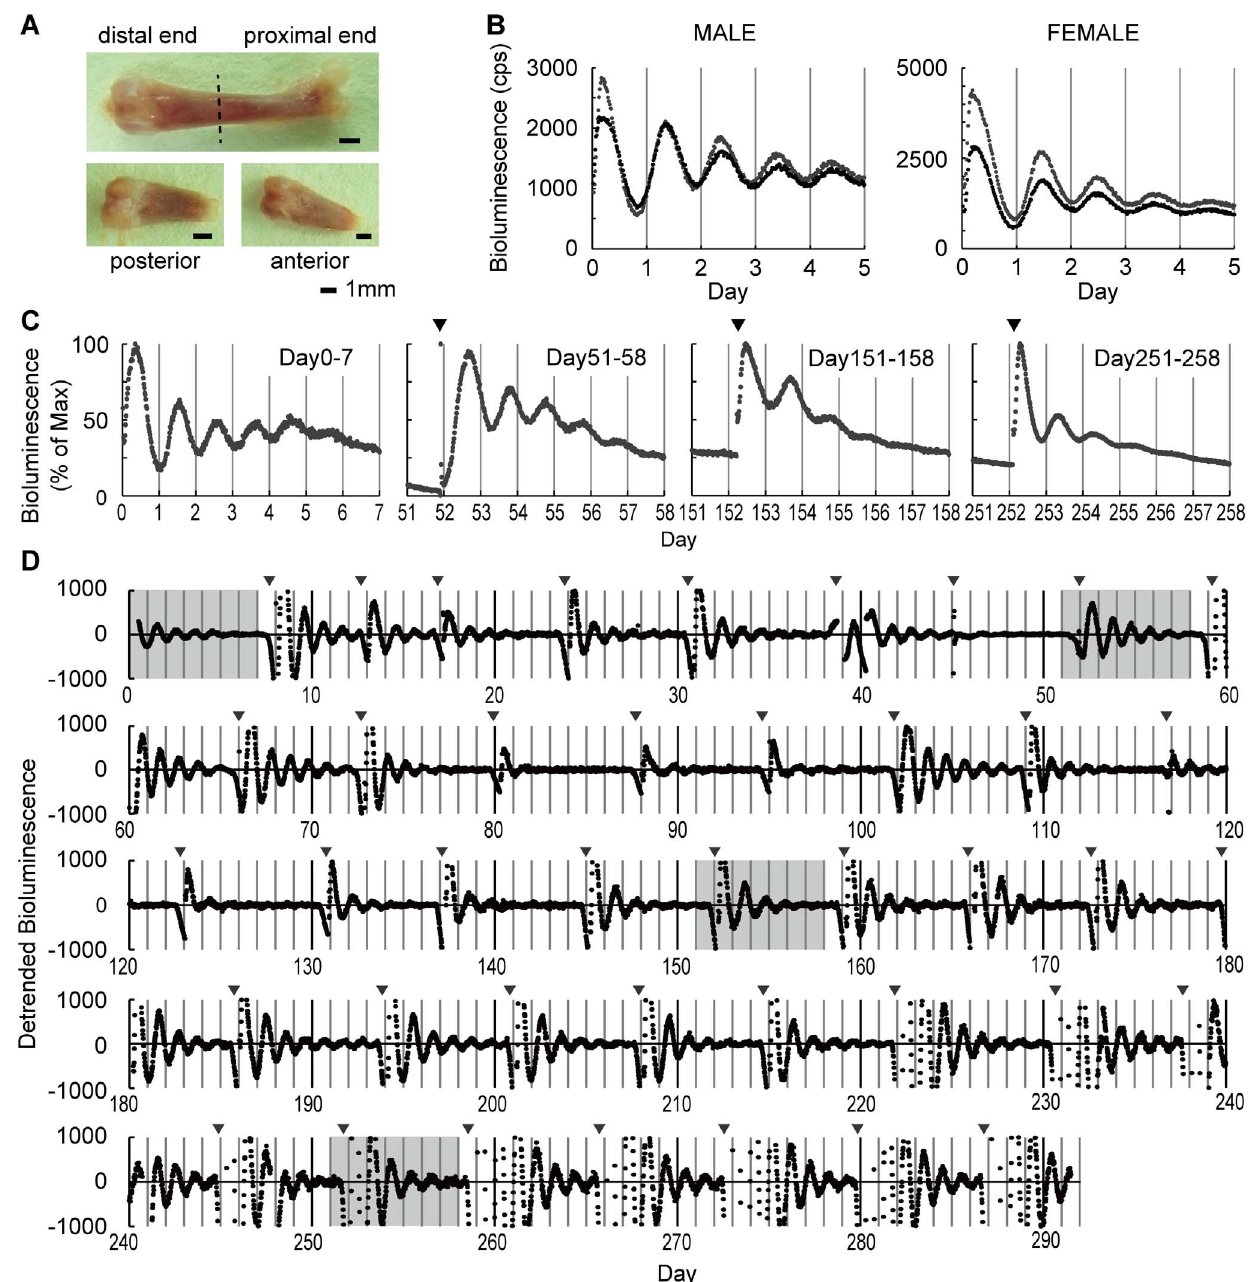
Figure 1. Persistent cell-autonomous oscillators in the bone. ( A ) Mouse femurs harvested from PER2 Luc mice. Distal femoral ends were used. ( B ) Two representative (black and grey dots) bioluminescence circadian rhythm traces. ( C–D ) Medium change restored circadian oscillation after 280 days in ex vivo culture. Four representative periods are shown where data are expressed as a percent of the max value in 7 days ( C ), and the entire 292 days of ex vivo culture data are shown in D . Data were detrended by a 24-hour moving average and the grey area is equivalent to data shown in C . Arrowheads indicate medium change.